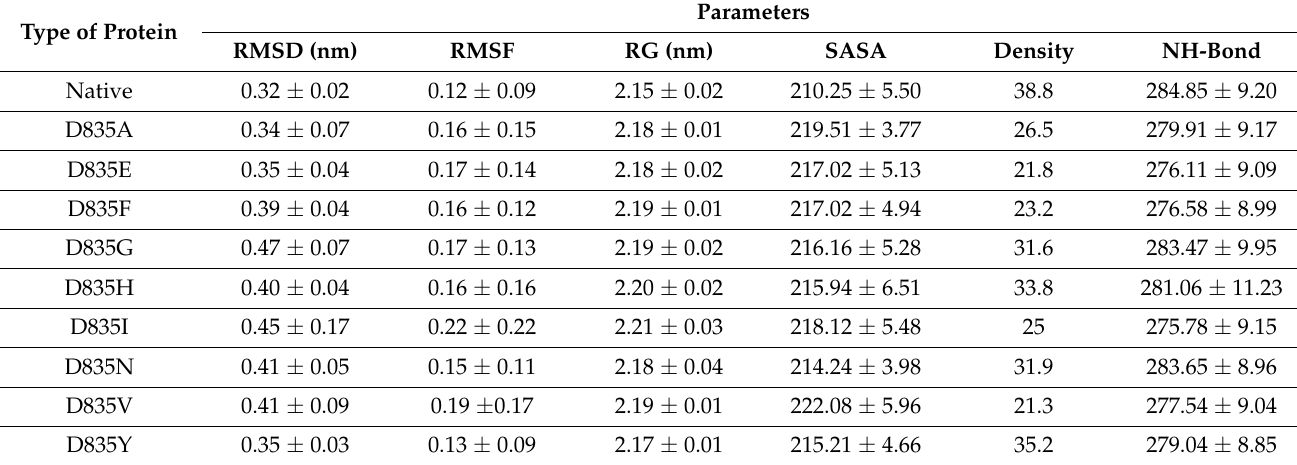
Table 1. Average values of RMSD, RMSF, Rg, SASA, Density and number of hydrogen bonds (NH-bonds), of Native and mutants FLT3. Type of